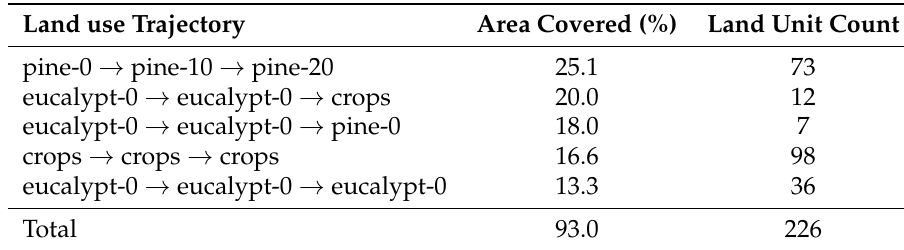
Table 13. Distribution of land use trajectories over the Tabacay catchment that optimizes land performance, obtained by applying BIOLP for the reference scenario and considering income and carbon stock thresholds (5 out of 25 assigned trajectories are